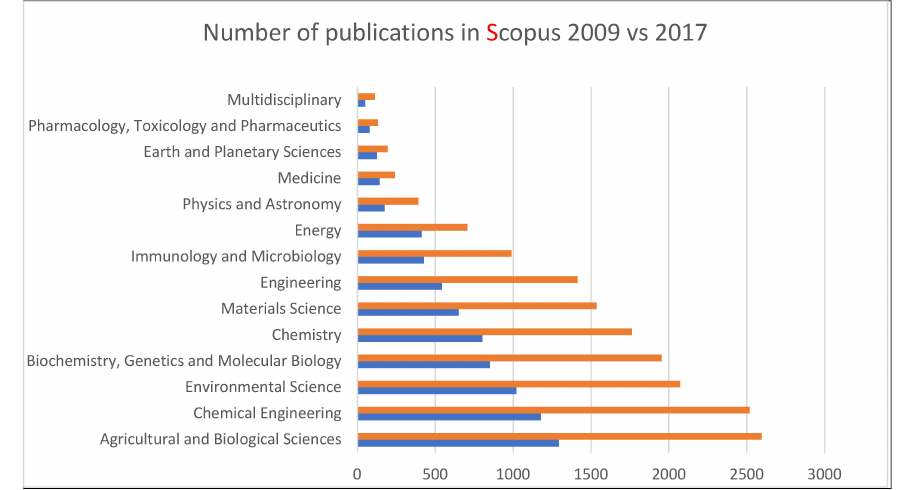
Figure 2. Distribution of the number of publications indexed in Scopus database, number returned using the keyword